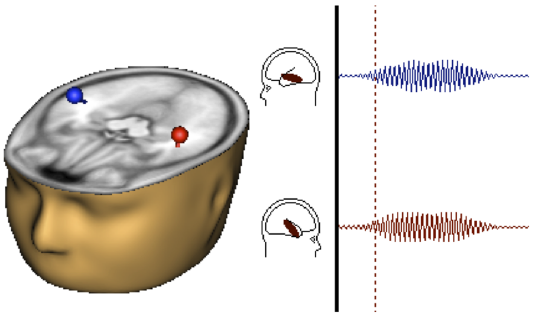
Figure 1. Signal-space projection. Representative diagram of placement of equivalent current dipoles and the resulting signal-space projected averaged waveform resulting from each